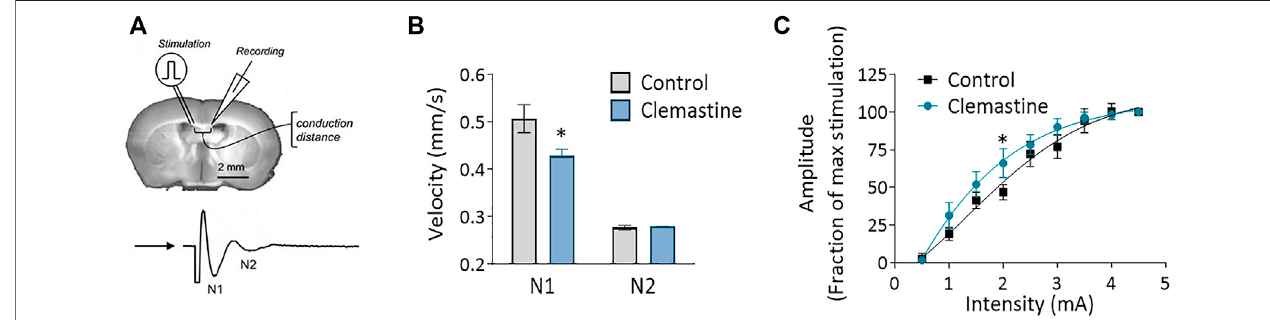
FIGURE 2 | (A) Schematic representation of compound action potentials (CAPs) recording in corpus callosum of 400 μ m coronal slices from P21 mice. (B) Conduction velocity corresponding to N1 and N2 peaks in vehicle ( n = 12) and clemastine-treated mice ( n = 10 – 12). For each mice, the average measure come from at leastfourdifferentsectionsrecordedthreetimes. (C) Theinput-outputrelationshipforN1myelinated fi bersisleft-shiftedinclemastine-treated corpuscallosum ( n =7 – 8). * p <